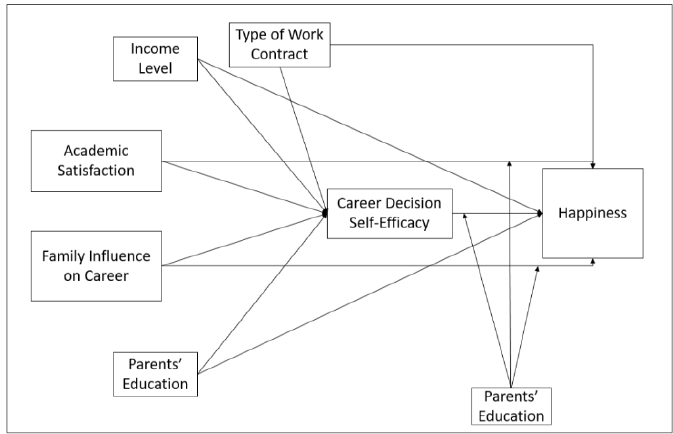
Figure 1. Research conceptual model.